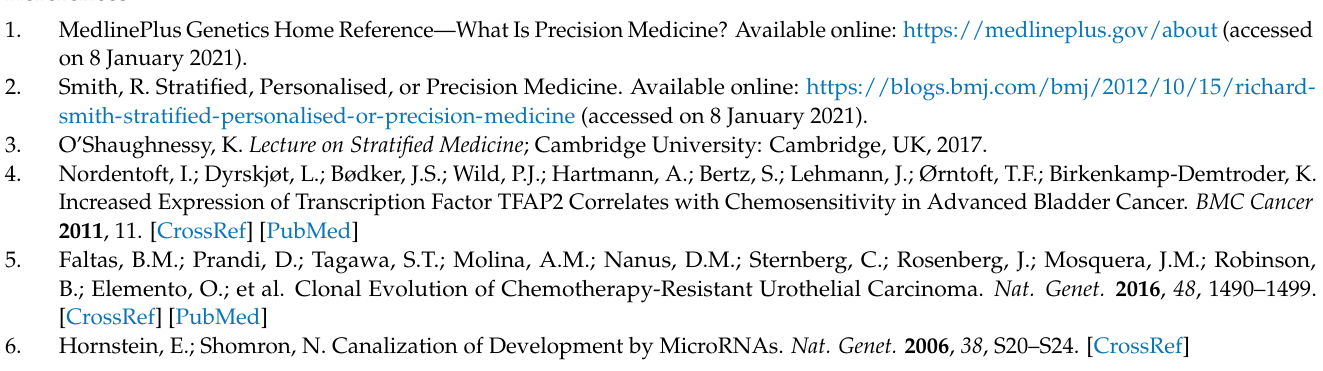
Supplementary Materials: Figure S1: Heatmap showing all corelations between selected gens and miRNAs as PDF; Figure S2: Interactive heatmap showing all corelations between selected gens